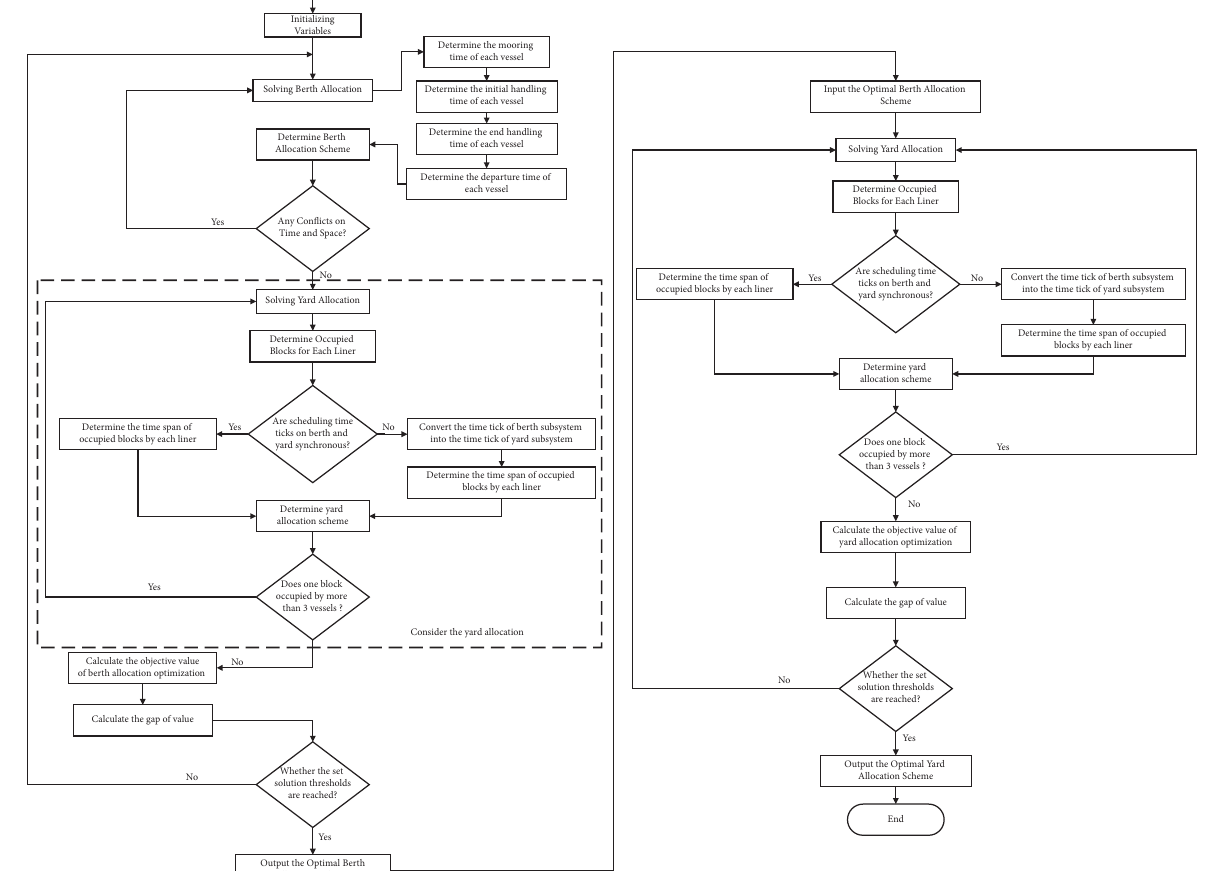
Figure 3: The solving process of staged scheduling strategies for BYCA-TSIS and